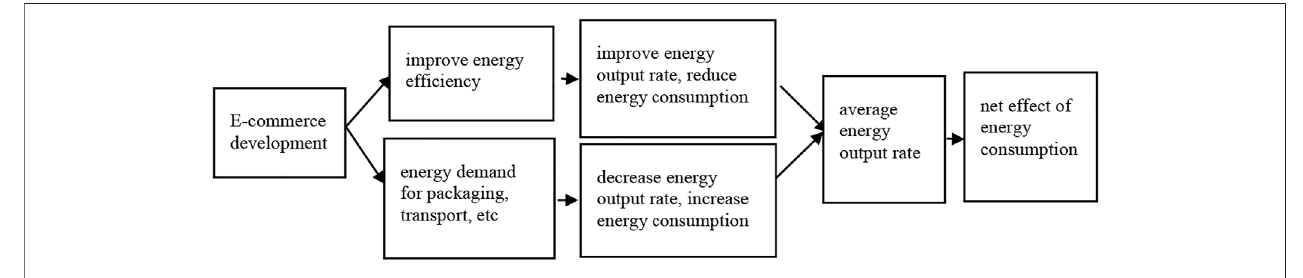
FIGURE 1 | Analysis of theoretical impact